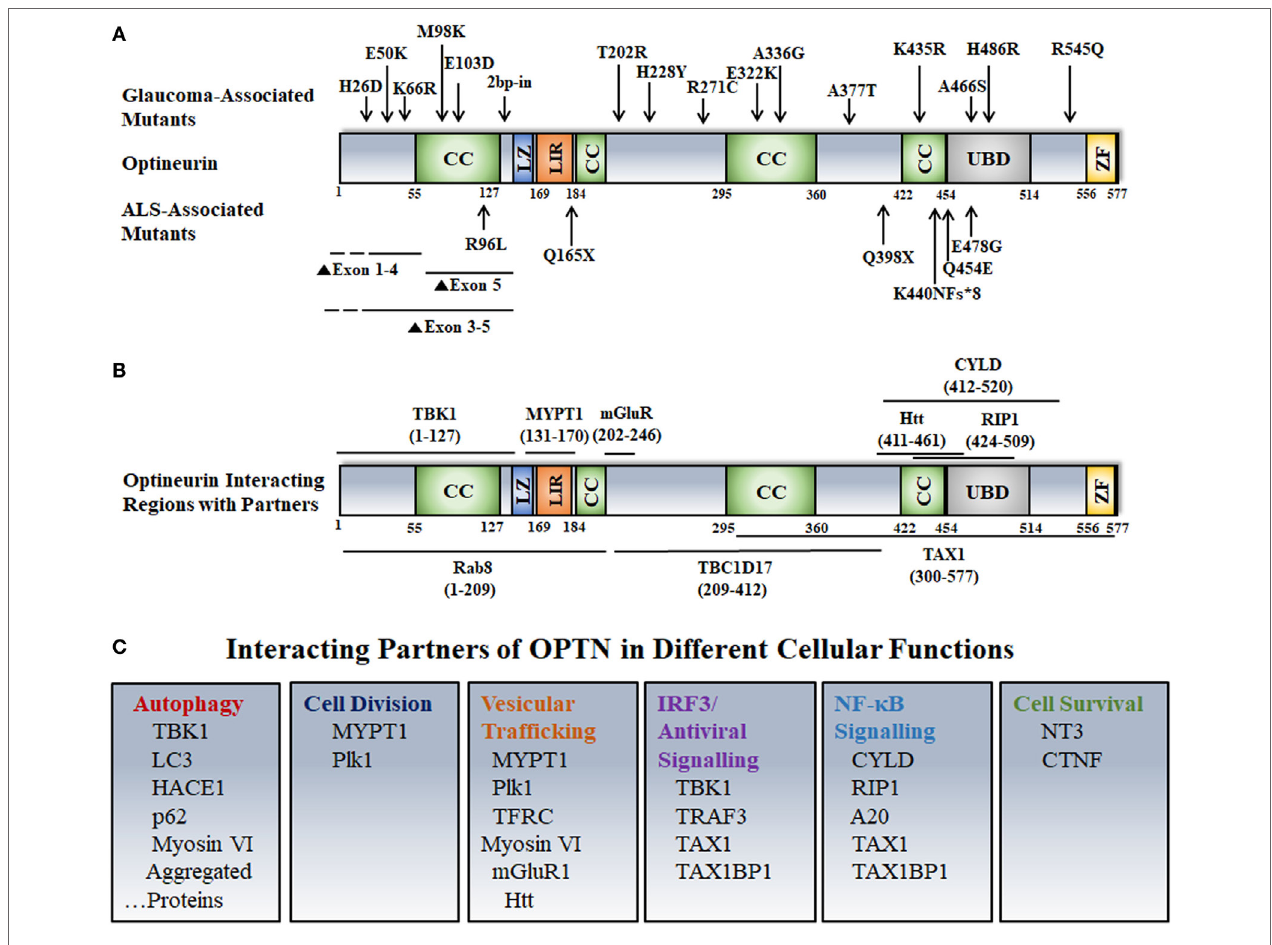
FiGURe 1 | Disease-associated mutations, interactions, and cellular functions of optineurin. (A) Various domains and disease-associated mutants of OPTN are shown. Abbreviations: CC, coiled coil; LZ, leucine zipper; LIR, LC3 interacting region; UBD, ubiquitin-binding domain; ZF, zinc finger. (B) OPTN-interacting proteins and their binding sites on OPTN are shown. (C) Interacting partners of OPTN involved in various cellular functions are